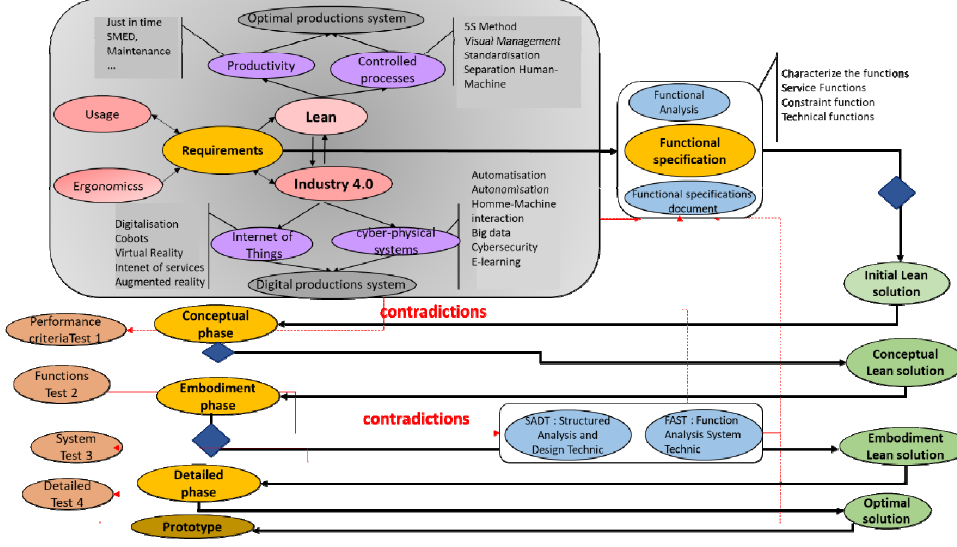
Figure 2. Framework of the proposed approach